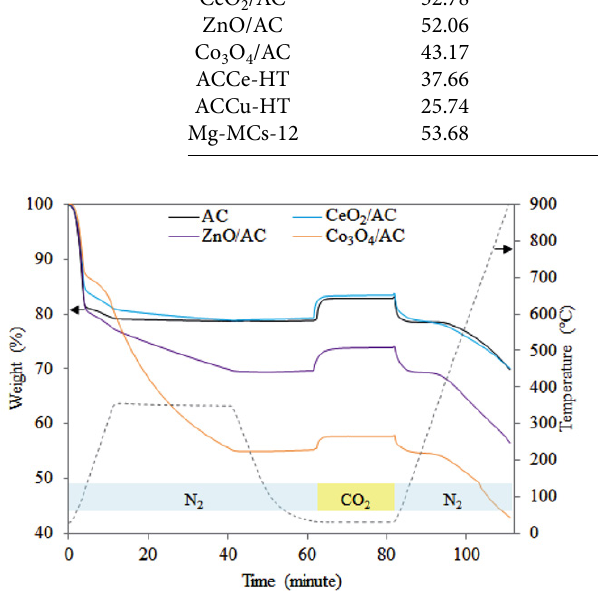
Figure 5. Simultaneous CO 2 adsorption and desorption for all ad- sorbents with adsorption temperature of 30 °C.